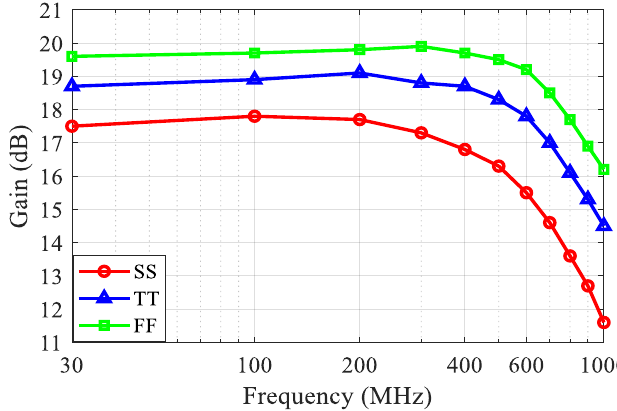
Figure 12. Simulated frequency response of the proposed LNA.